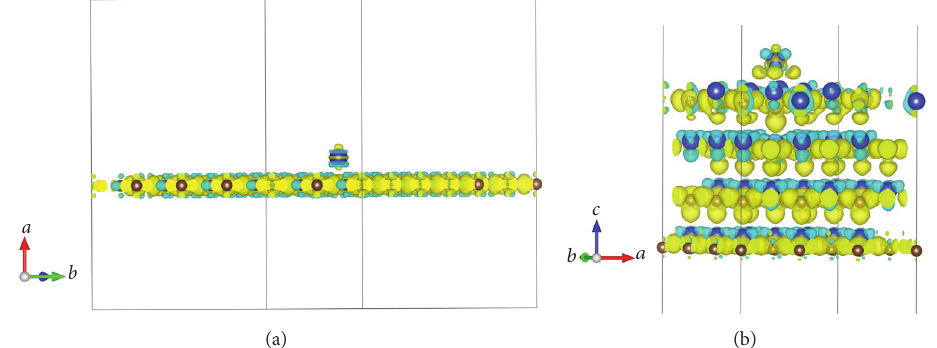
Figure 4: The CDD of Co at different substrate. (a) The Co adatom at graphite. (b) The Co adatom at